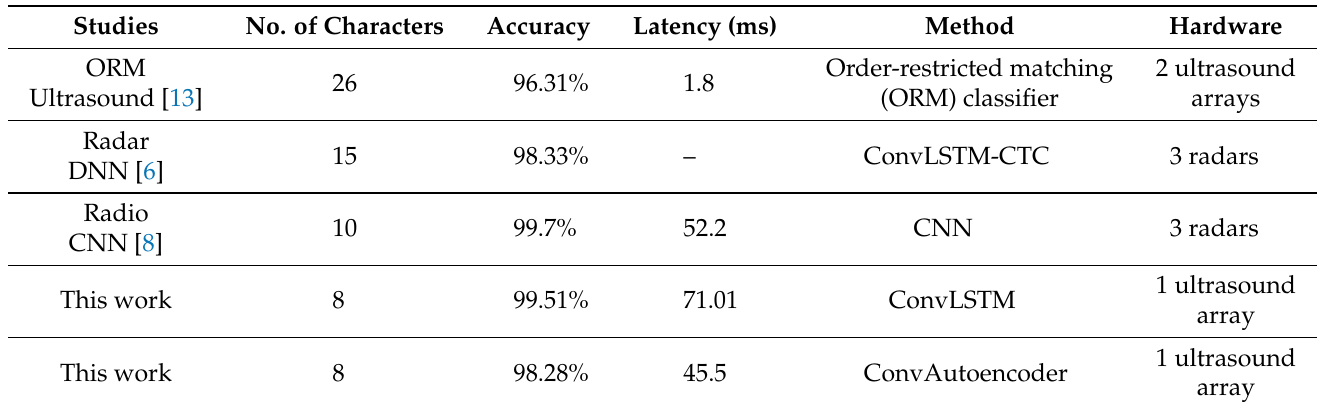
Table 3. Comparison of state-of-the-art techniques for